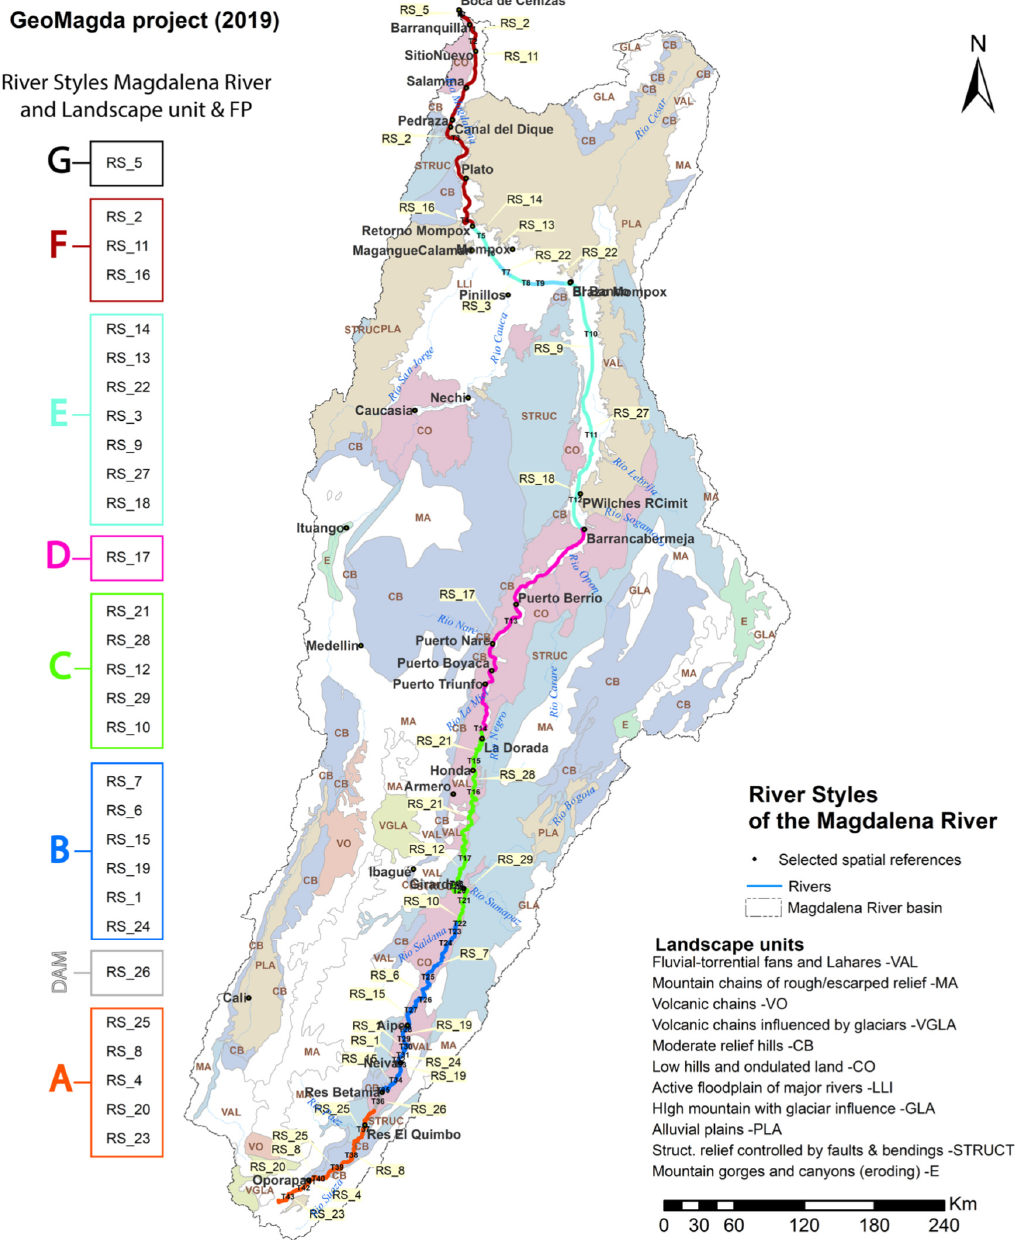
Figure 9. Map of River Styles (pale yellow background labels within the map) identified in the Magdalena River (smaller, black labels identify reaches). Their meaning is specified in a resumed form in Table 1. The capital letters on the left (A → G) summarize groups of River Styles characterized by a common behavior at macro scale, as detailed within the text (see Table 3 and Figure 8 for details). The occurrence of River Styles according to their length is shown in Figure 10: Twelve RS cover about 80% of the total length.